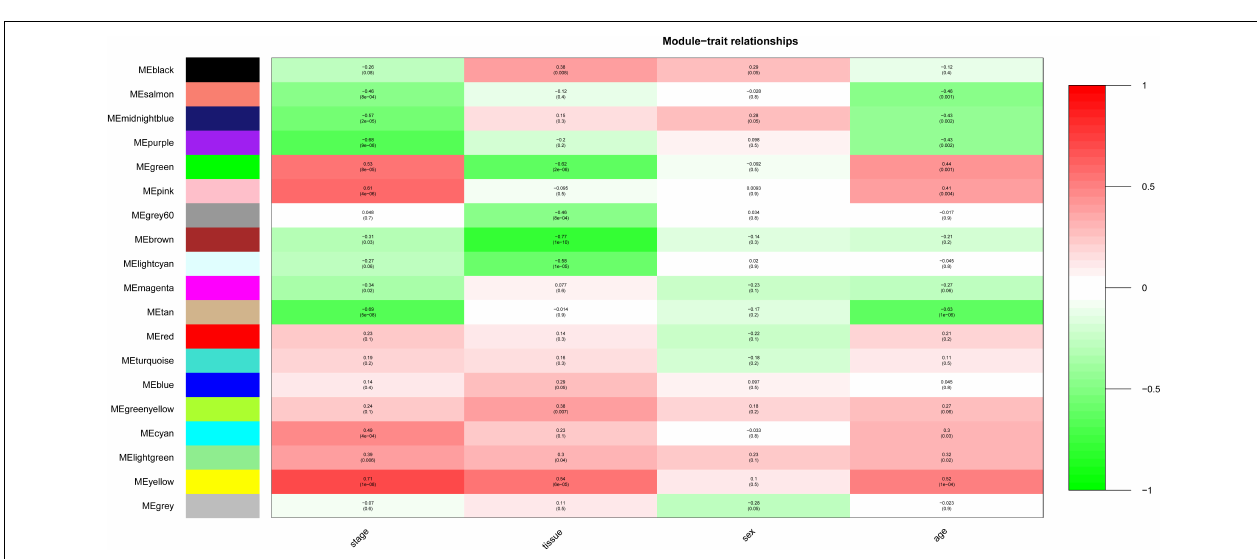
Frontiers in Physiology |